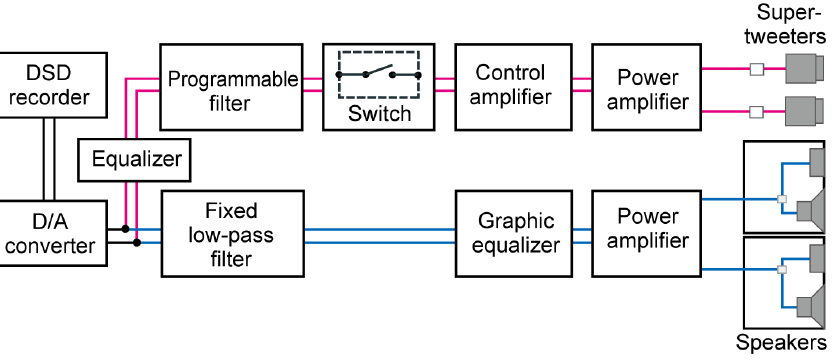
Figure 1. Block diagram of the frequency-variable sound presentation system. Each signal of the stereophonic sound material was divided into a low frequency component (LFC) and a high frequency component (HFC). The LFC was low-pass filtered at the cut off frequency of 16 kHz, while the HFC was band-pass filtered at arbitrary frequencies over 16 kHz by a programmable band-pass filter. The LFC and the HFC were independently amplified and reproduced through speakers and super-tweeters. Either LFC alone (control) or the LFC and an HFC together was applied to the subjects to observe the emerging state of the hypersonic effect.